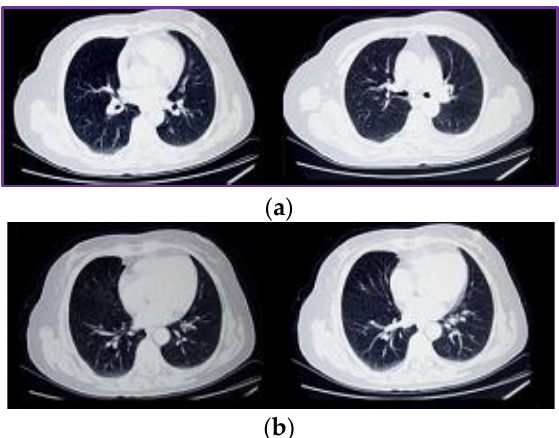
Figure 5. ( a ) Lung nodule positions for COPD (right) and non-COPD images. ( b ) Small changes in lung nodule positions for COPD and non-COPD images.